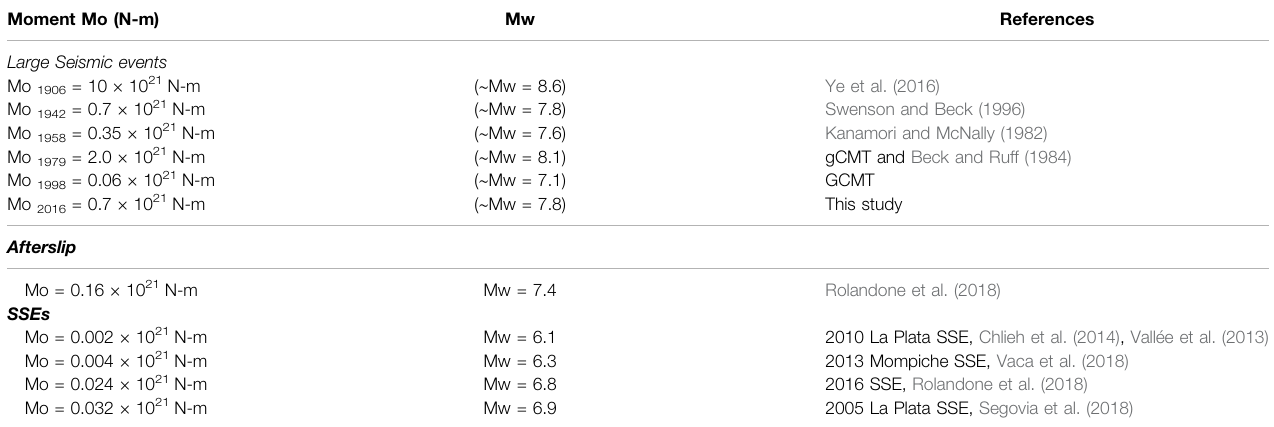
TABLE 1 | Moment Mo in Newton-meter (N-m) and corresponding moment magnitude Mw (Kanamori, 1977) for transient seismic and aseismic events observed along the Ecuador – Colombia subduction zone. Note that the cumulative seismic moment of the 1942, 1958, 1979, and 2016 earthquakes represents ∼ 35% of the 1906 seismic moment. Moment Mo